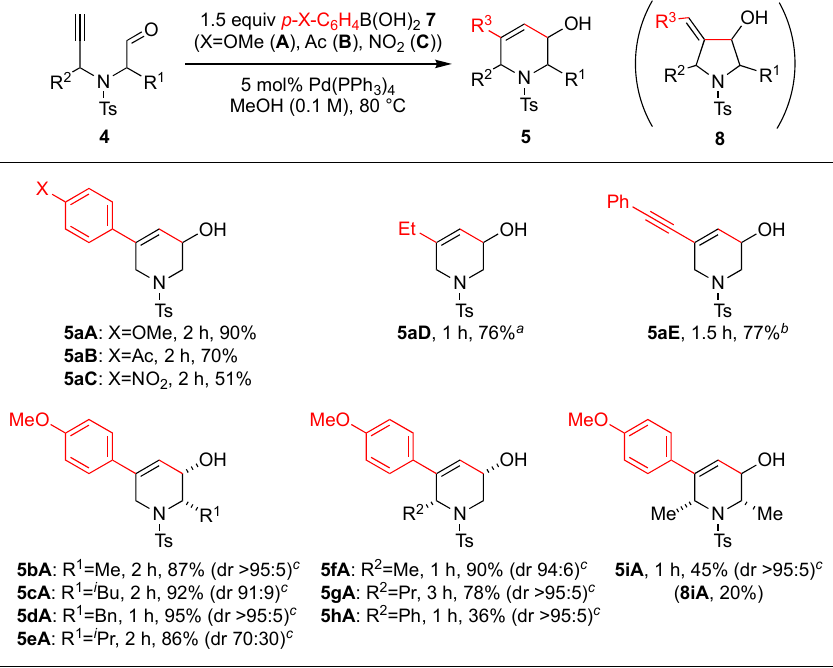
Scheme 3. Tetrahydropyridines prepared by Pd/PPh 3 -catalyzed cyclizations of terminal alkyne- aldehydes.